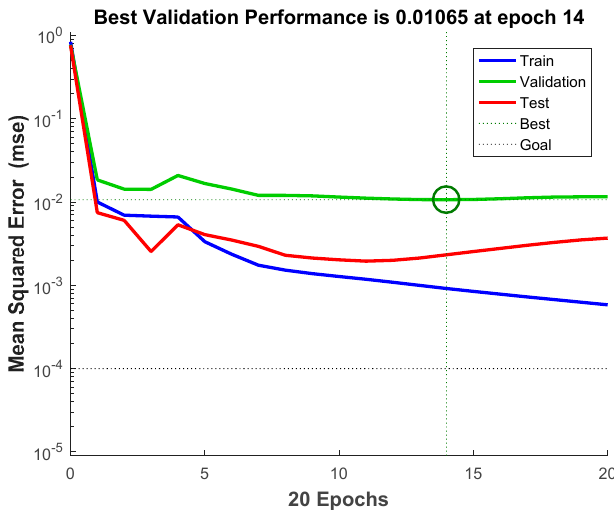
Figure 22. Error changes in the BPNN training process.